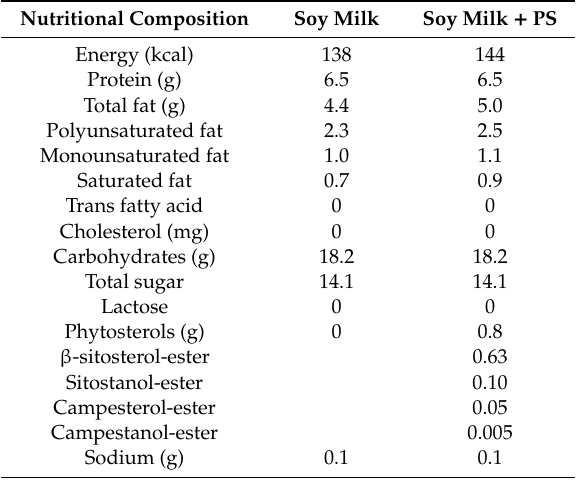
(Table 2). Blood samples were drawn from participants in the fasting state for biochemical analysis on the last day of each period study. Table 2. Soy milk nutritional composition per portion (200